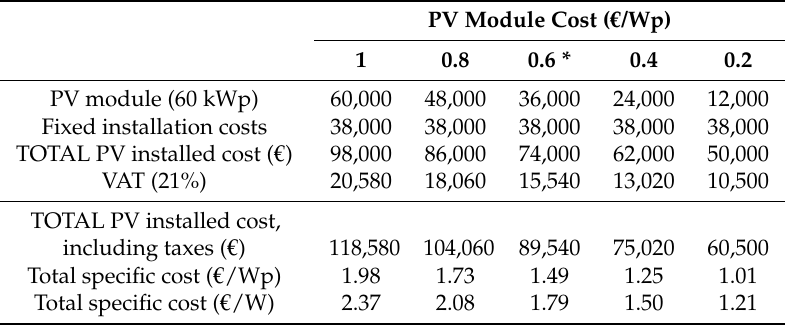
Table 7. Cost of a PV system at 60,000 Wp (50,000 W inverter).